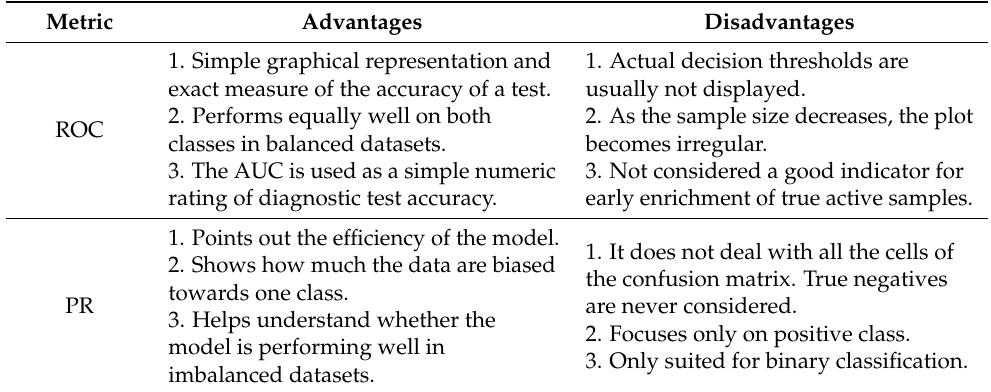
Table 1. Metric validation. The advantages and disadvantages of receiver operating characteristics (ROC) and precision–recall (PR) evaluation